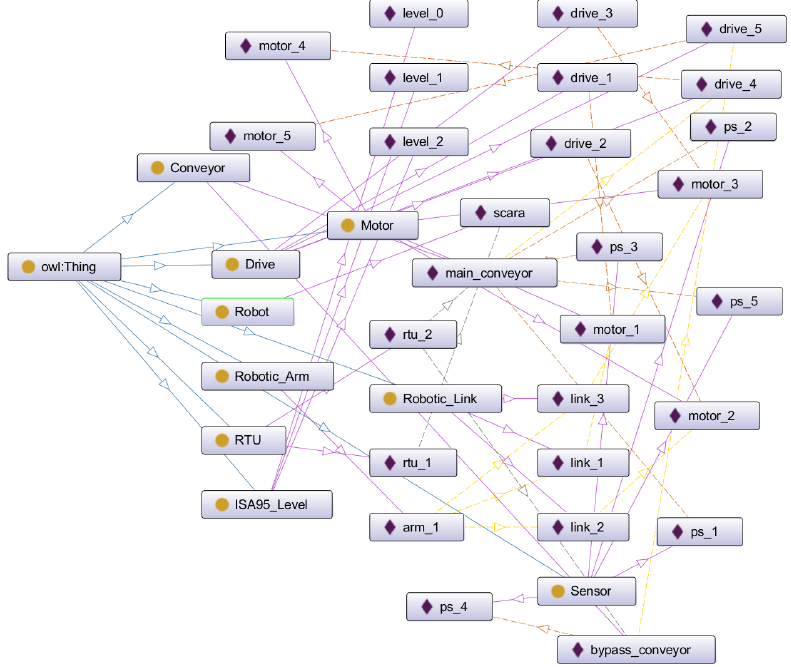
Figure 14. Snippet of the legacy ontology for the FASTory use case. [Source: Own figure which is a snapshot from Protege Ontology